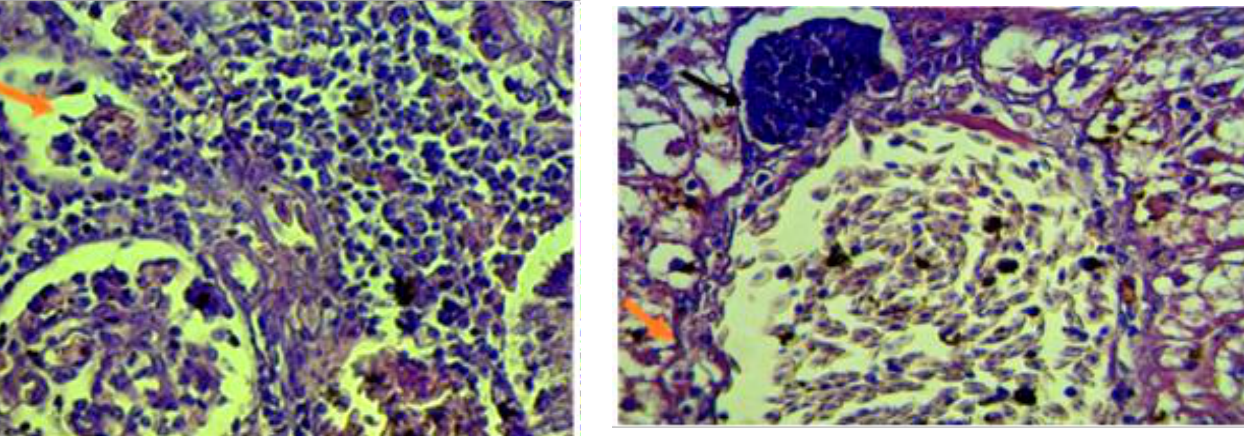
Figure 2. Histopathological section of kidney shows atrophy of glomerular tufts ( ) with thickening in bowman's capsules also vacuolation in some tubular epithelia ( )